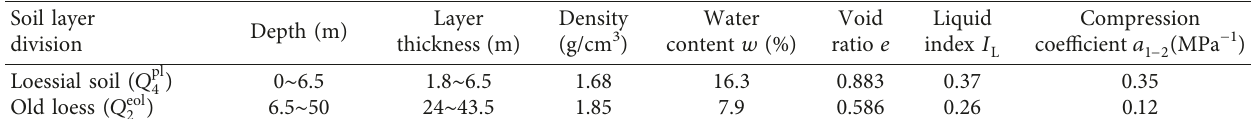
Table 1: Stratigraphic characteristics and physical indicators in experimental area.